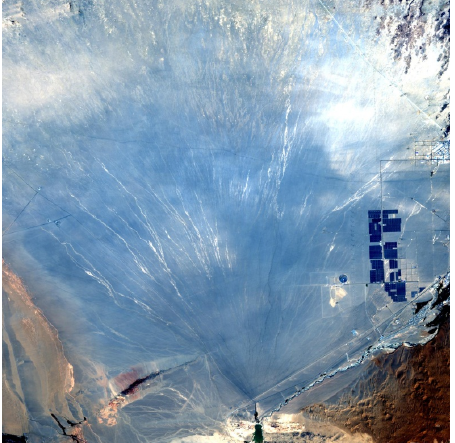
Figure 3. Landsat-8 OLI image of Dunhuang Desert (Colour synthesis with band 4, band 3 and band 2)